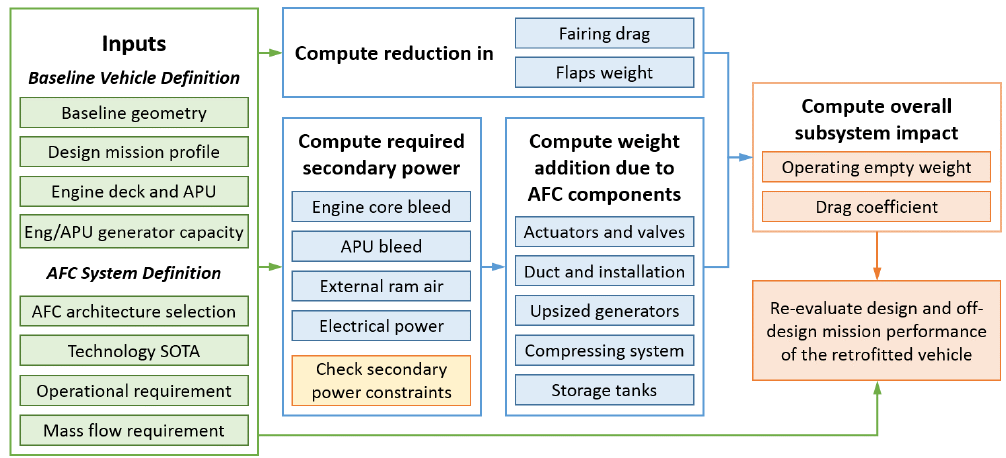
Figure 4. Illustration of sizing and analysis approach for considered HLAFC